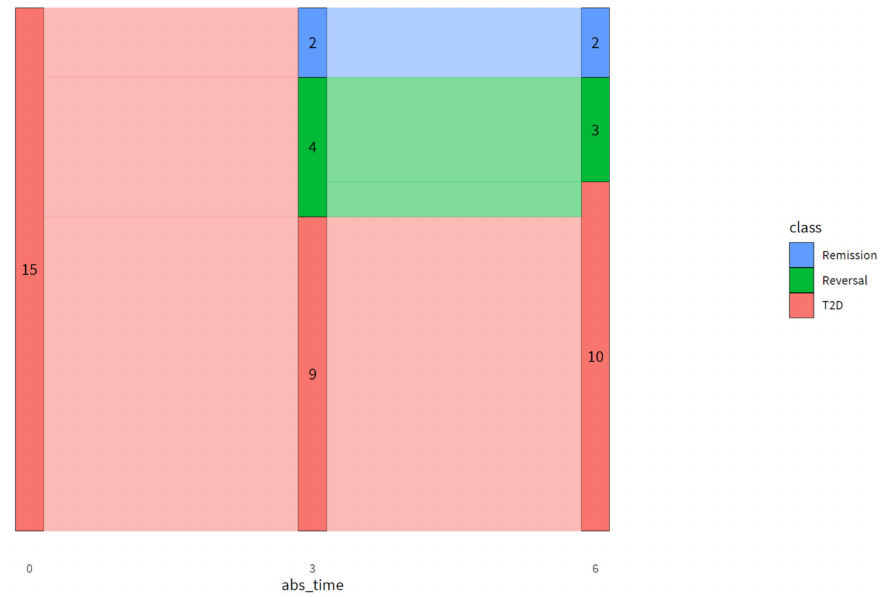
Figure 2. The number of participants who were classified as having T2D, in reversal, or in remission of T2D after three months and six months of intervention compared to baseline. Remission was defined as FPG ≤ 6.9 mmol/L and HbA1c < 48 mmol/mol and no medication use. T2D reversal was defined as attaining target values for HbA1c ( ≤ 53 mmol/mol) and fasting glucose (< 8.0 mmol/L) (Barents et al., 2018) with reduced medication (taking fewer types or a lower dose of glucose-lowering medication at three or six months compared to the start of the trial) or attaining normalized HbA1c (< 48 mmol/mol) and fasting glucose ( ≤ 6.9 mmol/L) with equal medication at three or six months compared to the start of the trial. Abs_time: time of intervention (months). Numbers within the figure indicate the number of participants with that particular classification at each time of